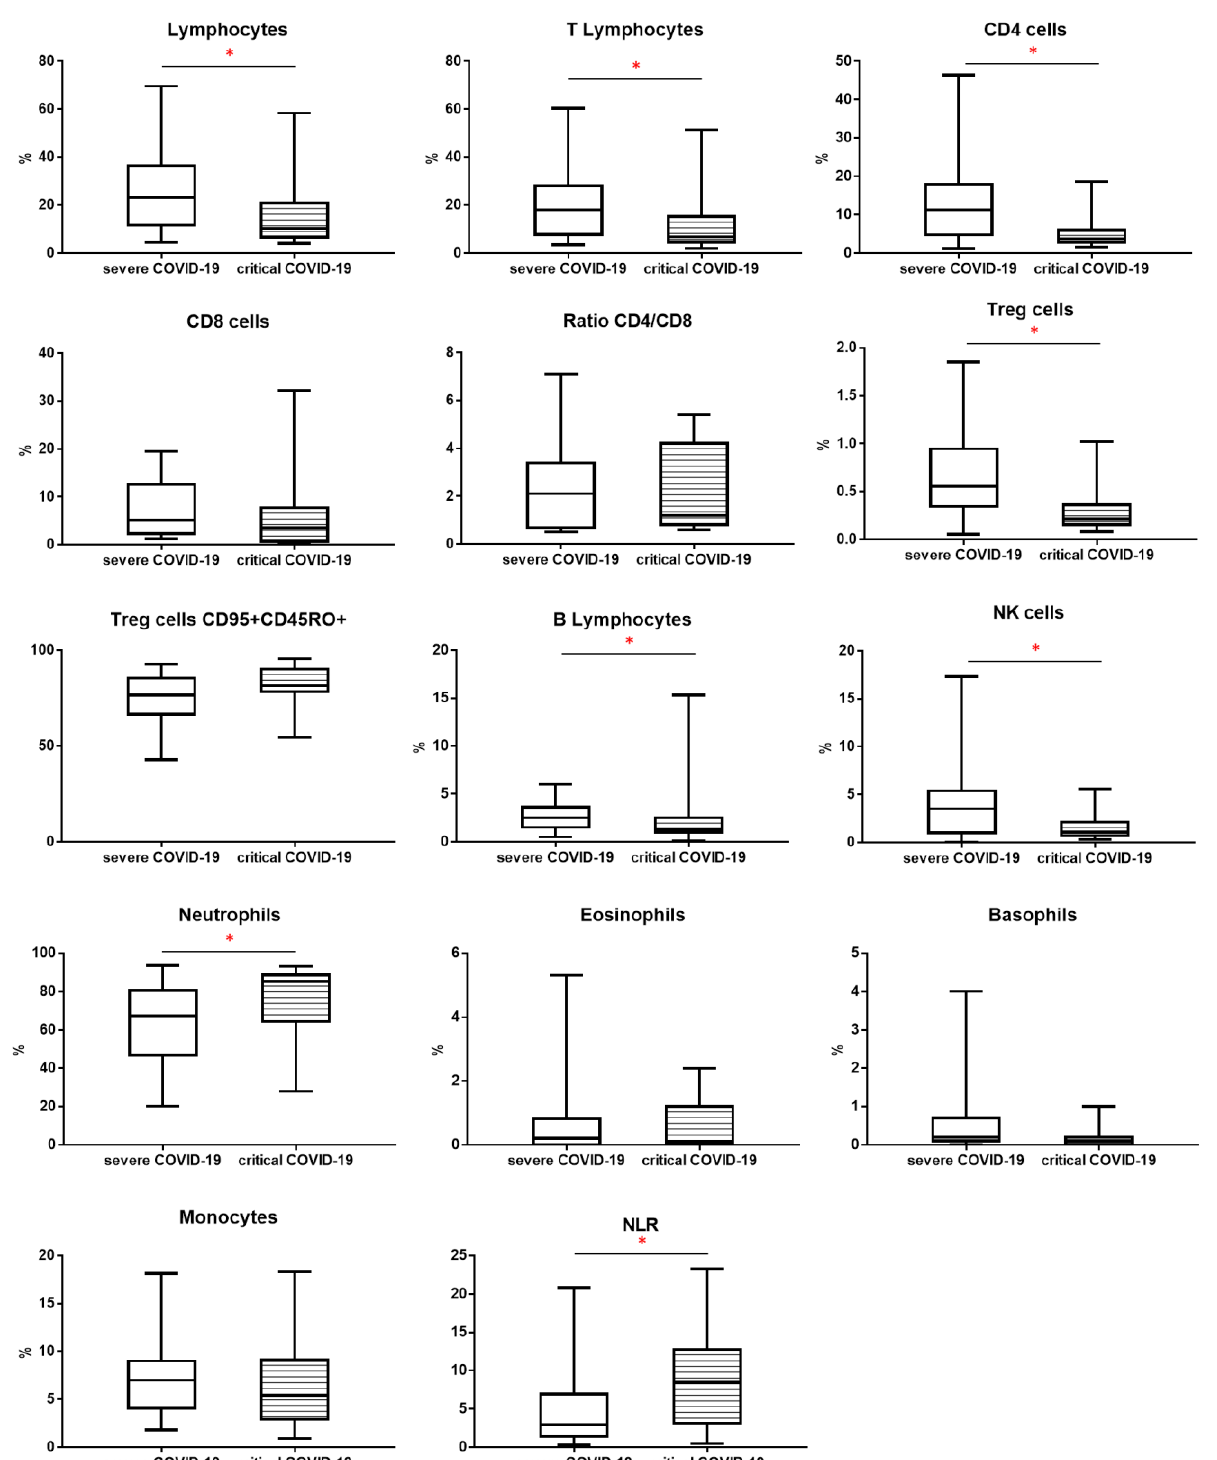
Figure 2. The differences of percentage of leukocytes, lymphocytes subpopulation and NLR between patients: with severe COVID-19 and critical COVID-19. Graphs show the median values (Min-Max) * p < 0.05. Lymphocytes, T, B, CD4, CD8, NK cells, T regulatory (Treg) cells, neutrophils, eosinophils, basophils and monocytes are presented as % of leukocytes. Treg cells CD95+ CD45RO+ is presented as % of Treg cells.